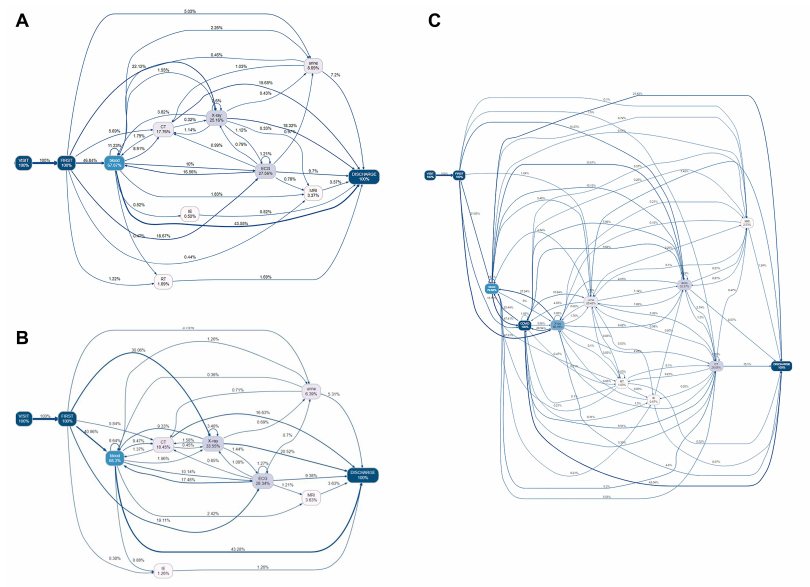
Figure 2. Process changes in ED patients before and after the COVID-19 pandemic. The top 65% of the most frequent process flow is shown in the figure. The arrow indicates process progression. The number above the line indicates the percentage of patients who followed the previous process to the process where the arrow points (%). Visit: time of the first visit to the ED. ( A ) Phase 1, ( B ) Phase 2-CTG, ( C ) Phase 2-CNTG. First: triage; IE: interventions and endoscopy; COVID-19: coronavirus disease; PCR: polymerase chain reaction; RT: nasal and sputum sample-based respiratory test; ECG: electrocardiography; Blood: blood sample-based laboratory tests; CT: computed tomography; discharge: time when the discharge order or the admission order was given.